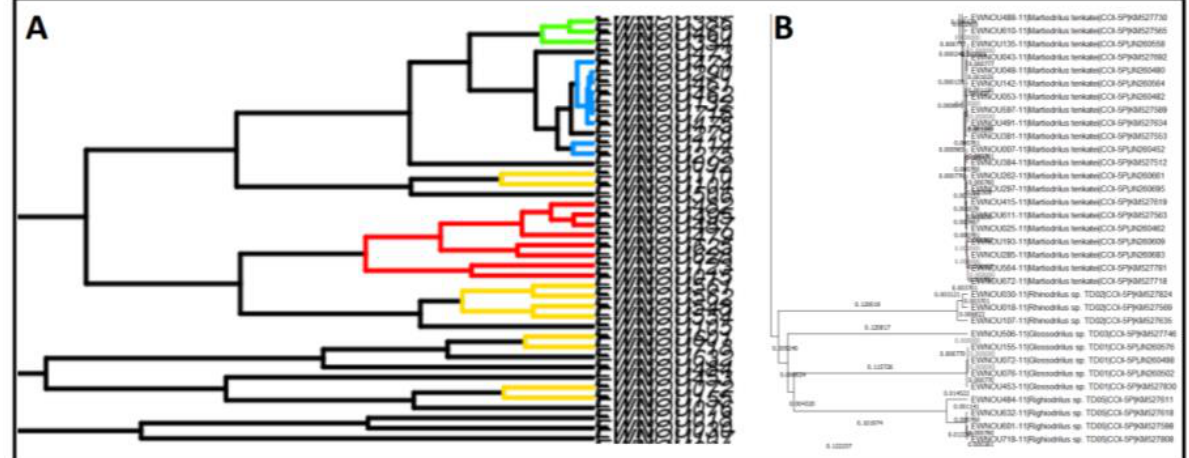
Figure 2. Output results obtained with the GMYC method: ( A ) extract of the output tree of the GMYC method in which the color codes allow the visualisation of OTUs delimitations; ( B ) extract of the input tree of the dataset which allows a more efficient visualisation of the identity of the leaves on the GMYC output